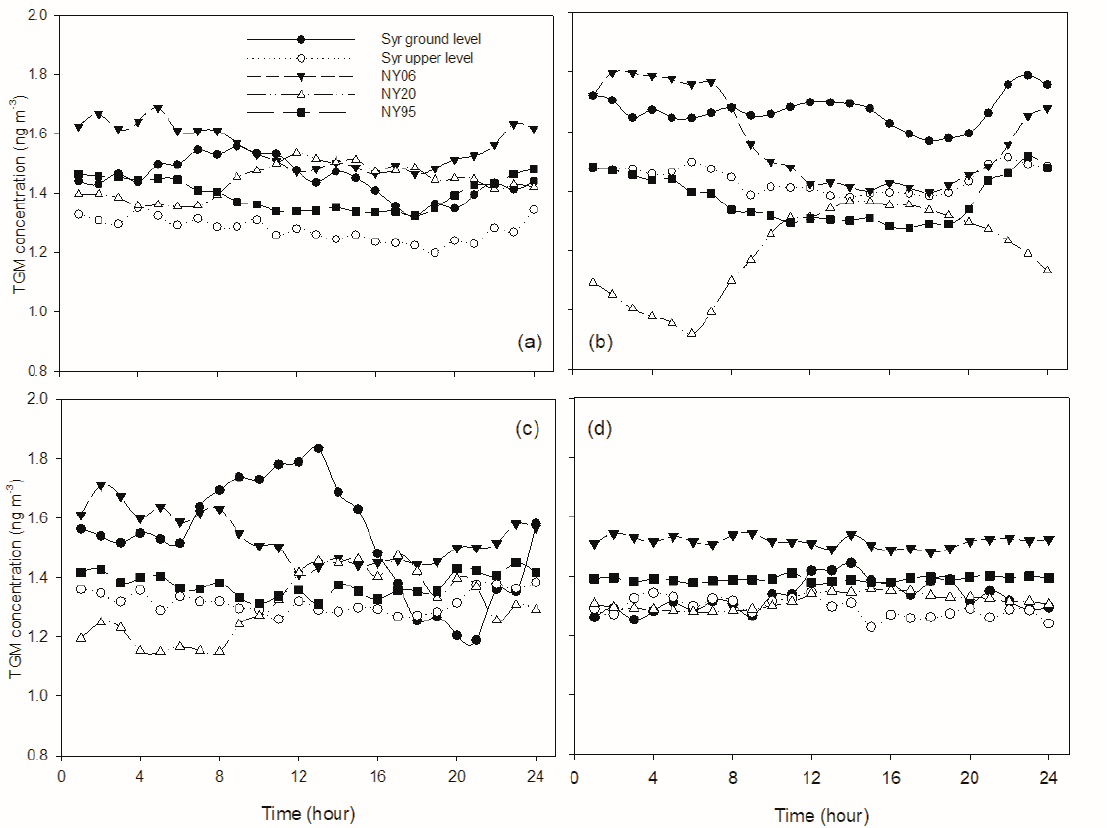
Figure 8. Comparison of seasonal TGM diurnal patterns for Syracuse CoE prior to brownfield remediation with AMNet sites in New York State, including ( a ) spring; ( b ) summer; ( c ) fall; and ( d ) winter (2011–2012).